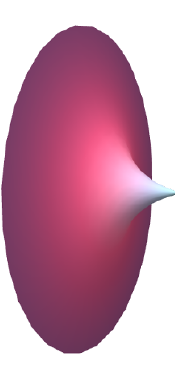
Figure 6. An artist’s impression of the internal space M 3 of the AdS 7 vacuum dual to the quiver in (5.7) with N = 80 and k = 10. The topology is that of a half- S 3 . (This is somewhat reminiscent of the half- S 4 internal space of the vacuum in [20], dual to the D4-D8-O8 (cid:0) con(cid:12)guration of [66].). The O8 (cid:0) source wraps its equator (i.e. is localized at the z = 0 pole). The z = N pole is of D6 type, i.e. is a singular point for the metric ds 2 . Notice that, in contrast to (cid:12)gure 1e, there are no M 3 black creases representing D8’s wrapping S 2 (cid:12)bers, since here n 0 =